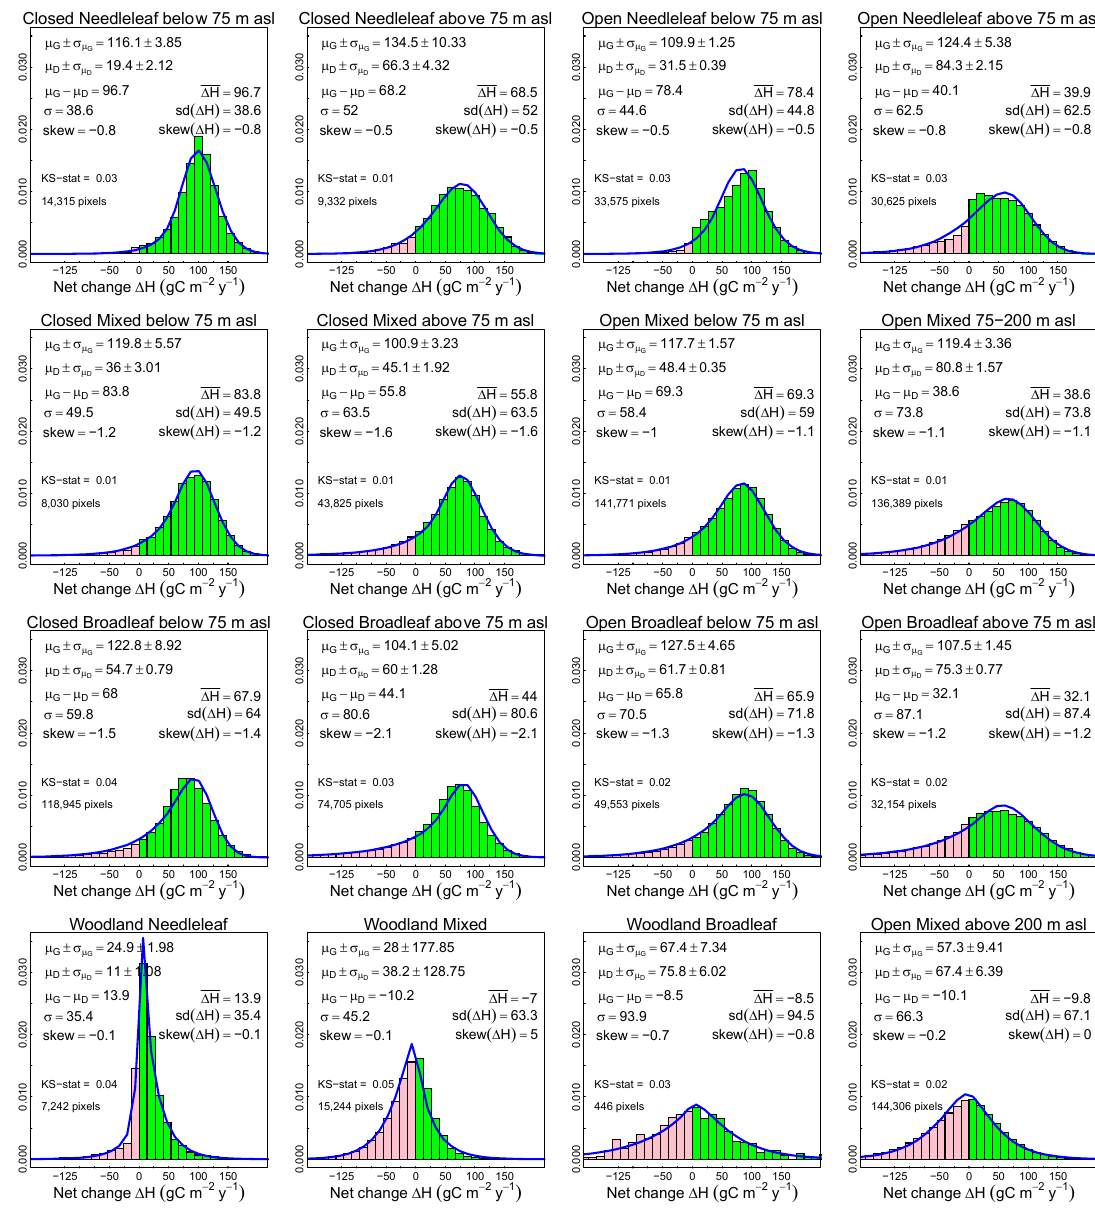
Figure 4. Histograms of observed distributions of net canopy carbon change ∆ H (green positive, pink negative) with superimposed best fit convolution (blue curve). µ G , µ D , σ µ , σ µ , µ G − µ D give means ± standard error of means, and difference of means for canopy NPP = G and canopy debris-fall = D , respectively, with descriptive statistics for ∆ H printed opposite the corresponding descriptive statistics for U = G − D from deconvolution so as to make model vs. observation comparison clear. KS-stat is the Kolmogorov–Smirnov test statistic often referred to as “D” in the literature. Pixel count gives sample size in histogram.